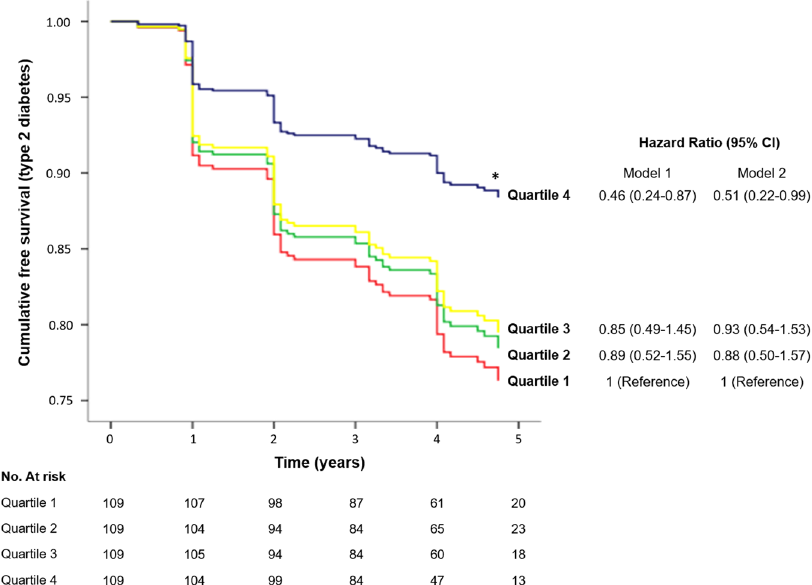
Figure 4. Cumulative T2DM free-survival by cholesterol efflux/apoA-I ratio quartiles. Cox regression models with outcome of T2DM are shown for quartiles of cholesterol efflux/apoA-I ratio, with the use of quartile 1 (subjects with the lowest cholesterol efflux capacity) as reference. Model 1 were adjusted by age, sex, BMI, smoking status, alcohol drinking, lipid-lowering treatment, hypertension, serum triglycerides and batch number. In Model 2, additional adjustment by Disposition Index, HOMA-IR and HbA1c were done. ( * p < 0.05 quartile 4 vs quartile 1).